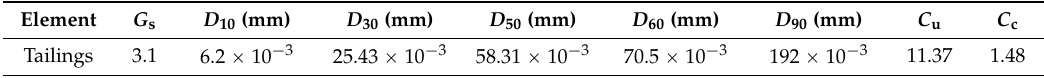
Table 1. Physical properties of the tailings used.